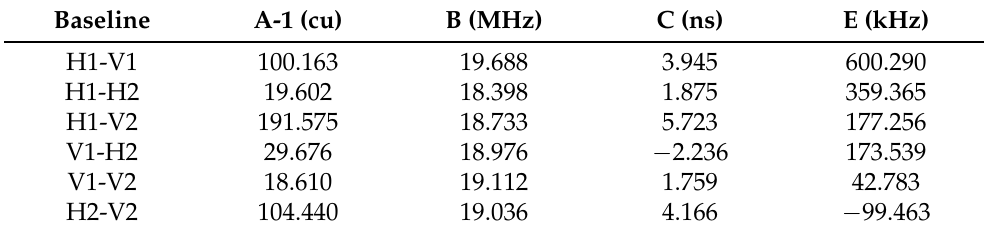
Table 3. Measured fringe washing function shape parameters. cu, correlation